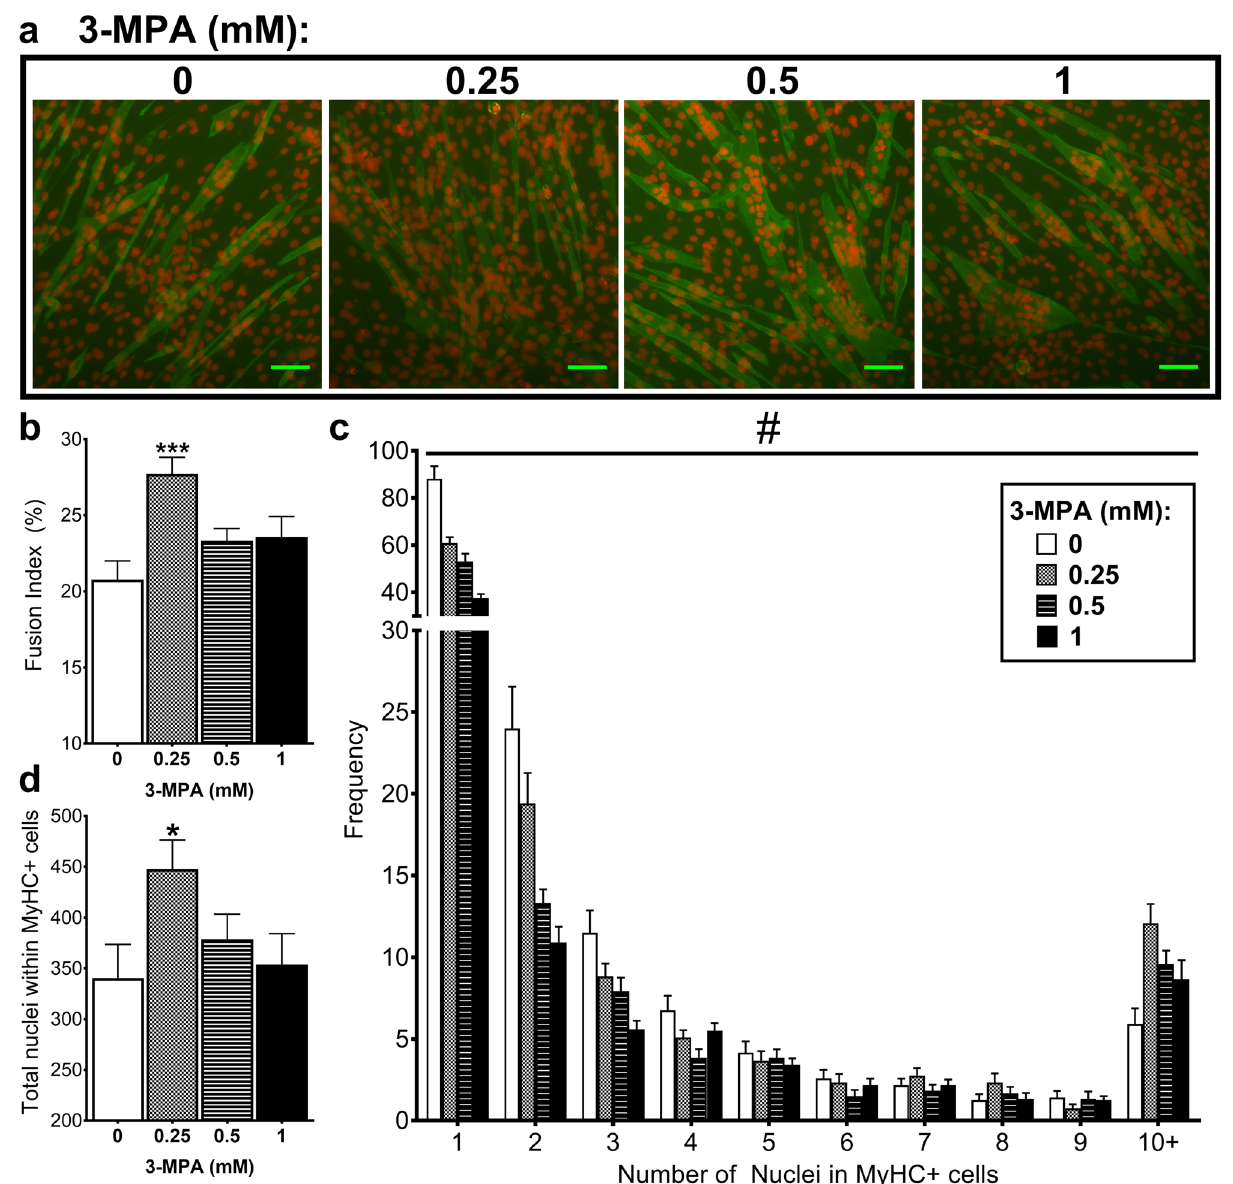
Figure 3. Treatment with 3-MPA increases fusion index. C2C12 cells were treated with 0, 0.25, 0.5 or 1 mM 3-MPA from day 0 of differentiation, then after 72 h treatment immunofluorescence was performed using MyHC antibody (green) and PI (red). ( a ) Photographs captured at 10X magnification. Scale bar: 100 µm. ImageJ software was used to quantify ( b ) Fusion Index, ( c ) the frequency of nuclei found within MyHC+ cells and ( d ) total nuclei number within MyHC cells. Data presented as Means (n = 12, from four wells per treatment and three fields of view per well) ± SEM. One- or two-way ANOVAs (blocking for ‘well’) were performed as appropriate, followed by Dunnett’s comparison test to the vehicle control (PBS; 0 mM 3-MPA). # P < 0.001 (treatment × nuclei number interaction) * P < 0.05, *** P <